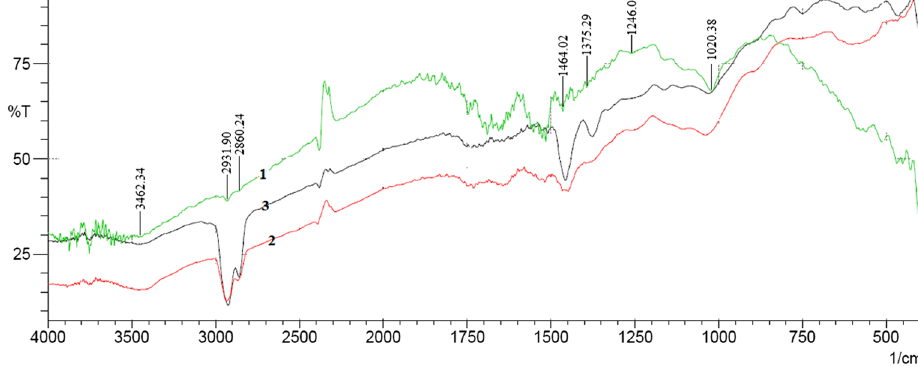
Fig. 4 FTIR spectra for unmodified [red (7) spectra] and modified [green (8) spectra] and crude oil-treated [black (9) spectra]